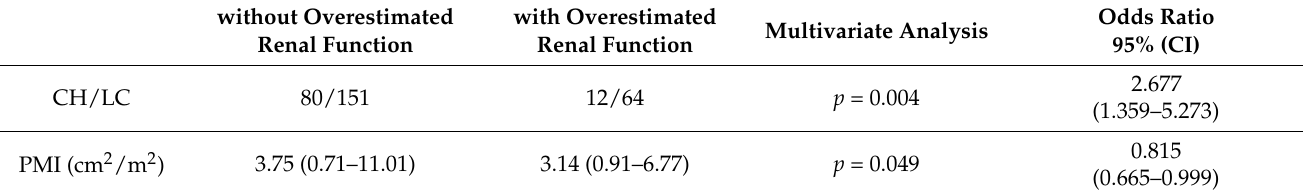
Table 2. Multivariate analysis for clinical factors associated with overestimated renal function in patients with CLD. without Overestimated